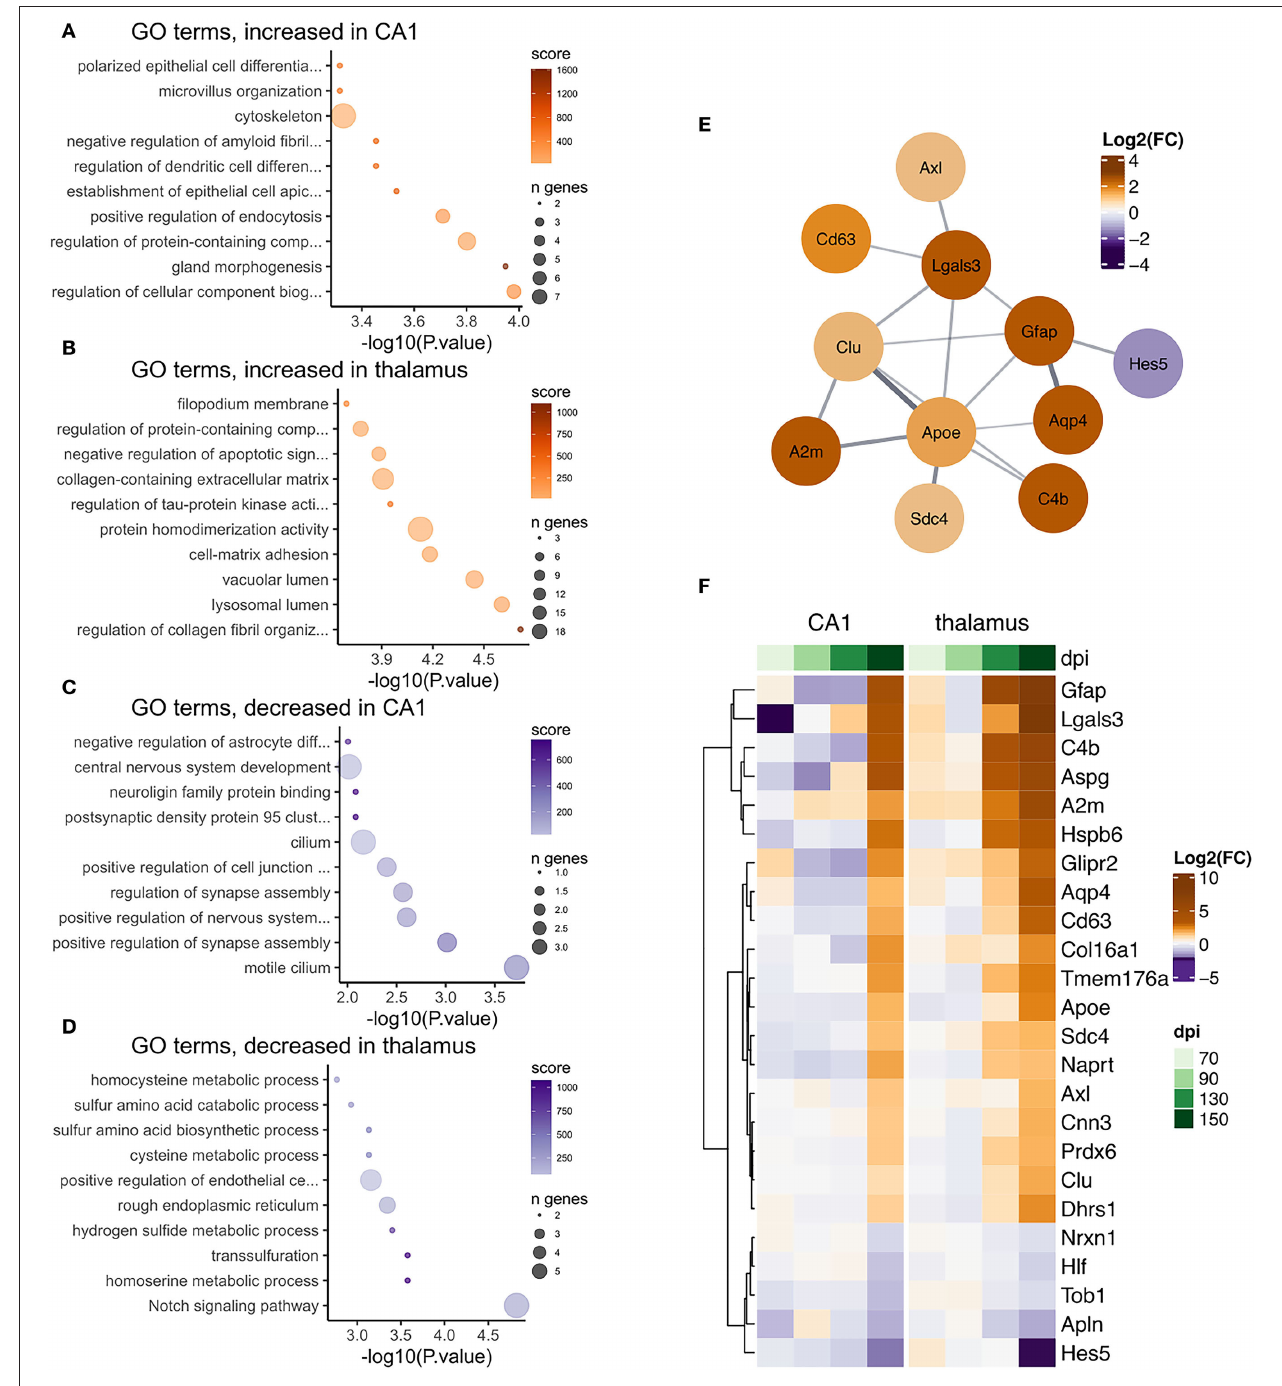
FIGURE 8 | Transcriptional changes affiliated with astrocytes in the CA1 and thalamus of RML infected mice. Enrichr was used to identify enriched gene ontologies for astrocyte affiliated transcripts that were (A) increased in the CA1, (B) increased in the thalamus, (C) decreased in the CA1, and (D) decreased in the thalamus. (E) STRING was used to construct a protein-protein interaction network of the 24 astrocyte transcripts that were commonly prion altered in the CA1 and thalamus. (F) A heatmap was used to visualize magnitude of change, expressed as log 2 fold-changes at each timepoint for the common astrocyte transcripts.